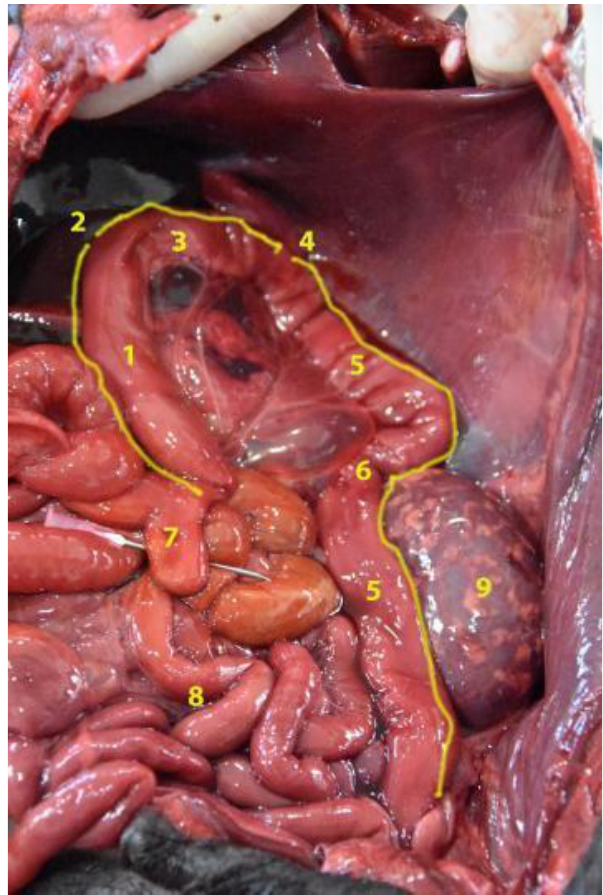
Figure 21. General view of the abdominal cavity (body in dorsal recumbency). Observe the colon with its different parts in situ. ( 1 ) Ascending colon; ( 2 ) right flexure of the colon; ( 3 ) transverse colon; ( 4 ) left flexure of the colon; ( 5 ) descending colon; ( 6 ) sigmoid of the colon; ( 7 ) cecum; ( 8 ) jejunum; ( 9 ) left kidney.